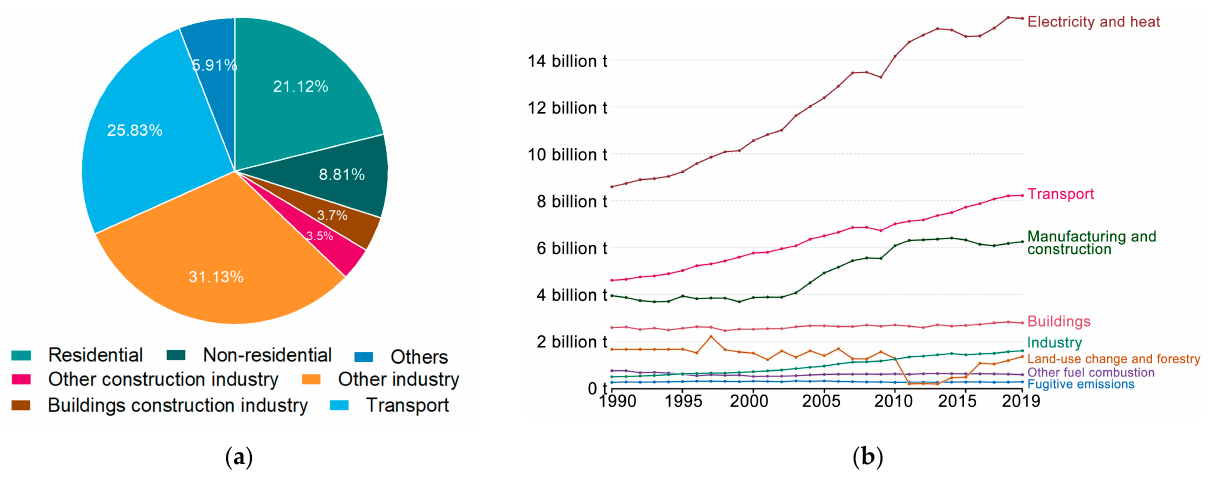
Figure 1. ( a ) Final energy consumption in the building sector, 2021; ( b ) worldwide CO 2 emissions by sector.